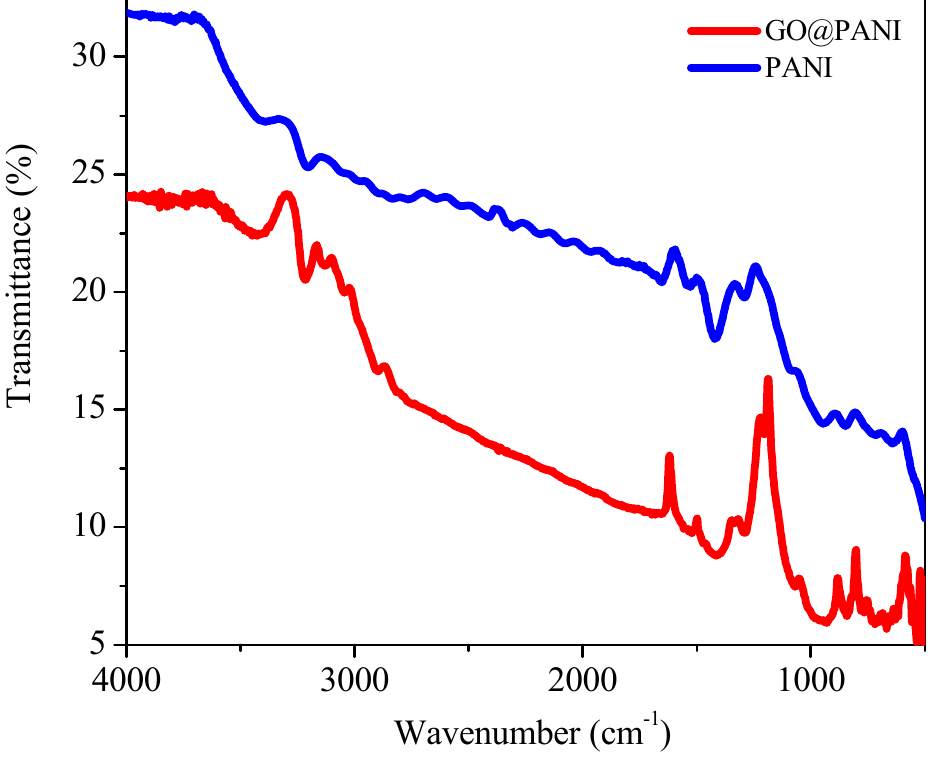
Figure 1. Fourier Transmission Infrared Spectroscopy (FTIR) spectrum of graphene oxide–polyaniline (GO@PANI) nanocomposite and PANI.